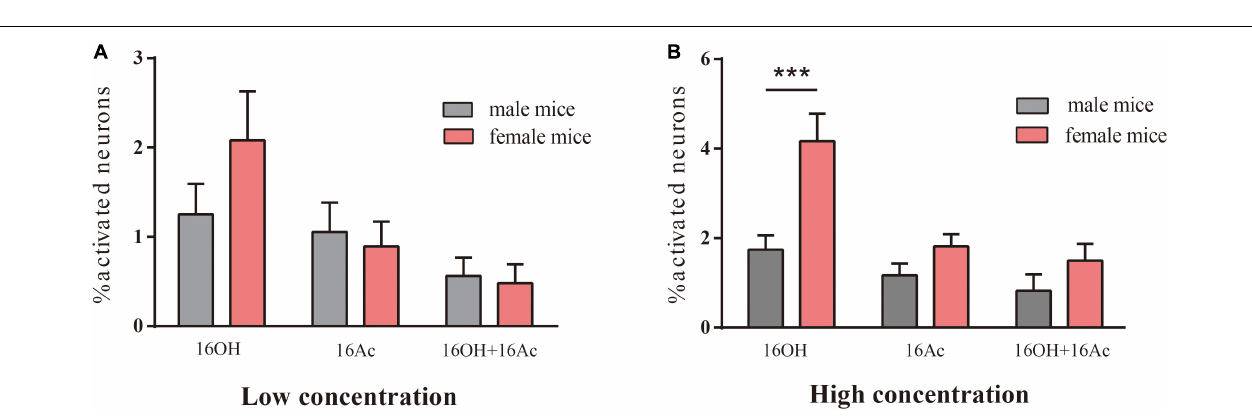
FIGURE 3 | Female VSNs respond differently to 16OH and 16Ac. (A) Comparison of the percentages of female VSNs responsive to 16OH and 16Ac at 10 nM. Out of 1168 cells examined, 23 responded to L-16OH, 10 to L-16Ac, and 6 to both. Significantly more cells responded to L-16OH than to both; and no significant differences in the numbers of cells responsive to L-16OH versus to L-16Ac or to L-16Ac versus to both were found (F-L-16OH vs. F-L-16Ac, t = 2.311, p = 0.341; F-L-16OH vs. F-L-16OH + F-L-16Ac, t = 3.116, p = 0.035; F-L-16Ac vs. F-L-16OH + F-L-16Ac, t = 0.805, p = 1.000). (B) Comparison of the percentages of female VSNs responsive to 16OH and 16Ac at 100 µ M. Out of 964 cells examined, 41 responded to H-16OH, 17 to H-16Ac, and 16 to both. Cells responsive to H-16OH were significantly more than those to H-16Ac or both but no significant difference was found between cells responsive to H-16Ac versus both (F-H-16OH vs. F-H-16Ac, t = 4.573, p = 0.000; F-H-16OH vs. F-H-16OH + F-H-16Ac, t = 5.196, p = 0.000; F-H-16Ac vs. F-H-16OH + F-H-16Ac, t = 0.623, p = 1.000). (C) Comparative analysis of the female VSNs responsive to the same pheromones at different concentrations. More female VSNs responded to H-16OH than to L-16OH whereas no significant differences were found between cell numbers responsive to H- versus to L-16Ac or between those to both H-16OH and H-16Ac versus both L-16OH and L-16Ac (F-H-16OH vs. F-L-16OH, t = 4.062, p = 0.001; F-H-16Ac vs. F-L-16Ac, t = 1.800, p = 1.000; F-H-16OH + F-H-16Ac vs. F-L-16OH + F-L-16Ac, t = 1.982, p = 0.751). All values are expressed as mean ± s.e.m. ∗ p < 0.05, ∗∗ p < 0.01, ∗∗∗ p < 0.001.